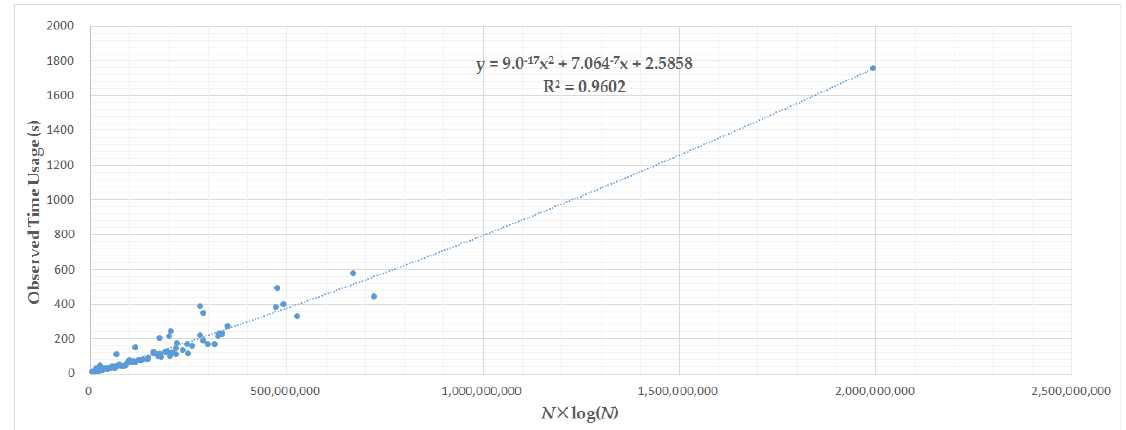
Figure 7. Second-order regression of P 2 (This is the relation between N × log ( N ) and the time usage in data clipping, where N is the number of vertices).